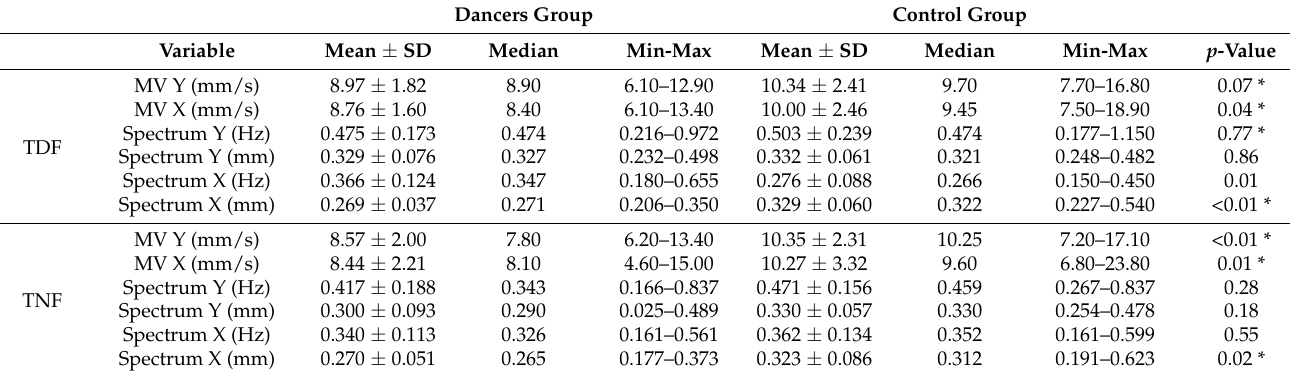
Table 4. Comparison of results obtained in the tandem position with the dominant foot in front (TDF) and with the non-dominant foot in front (TNF) in the dancer and control groups.